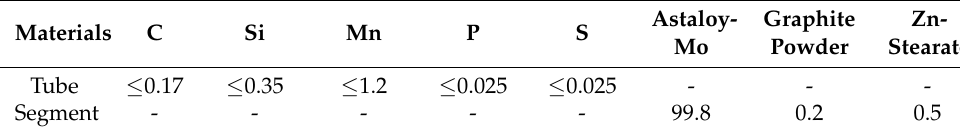
Table 1. Chemical composition of tube and powder metallurgy segment (wt %).